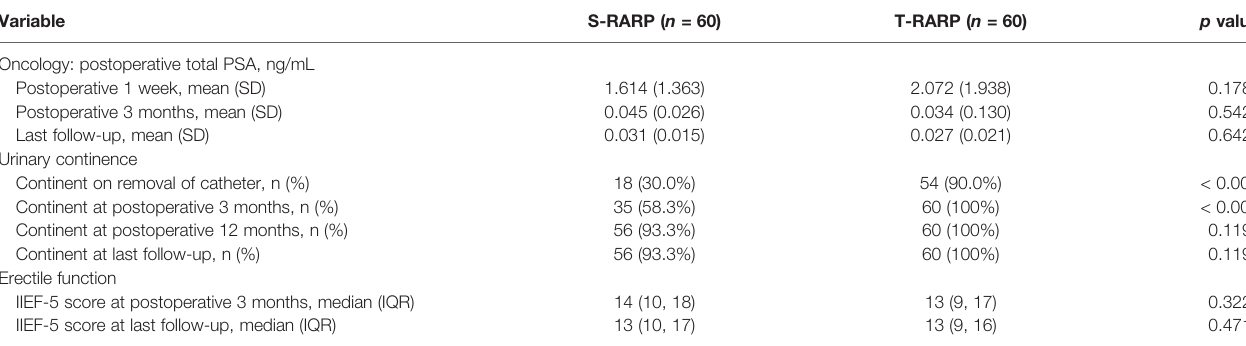
TABLE 3 | Postoperative outcomes for S-RARP and T-RARP after propensity score matching. Variable